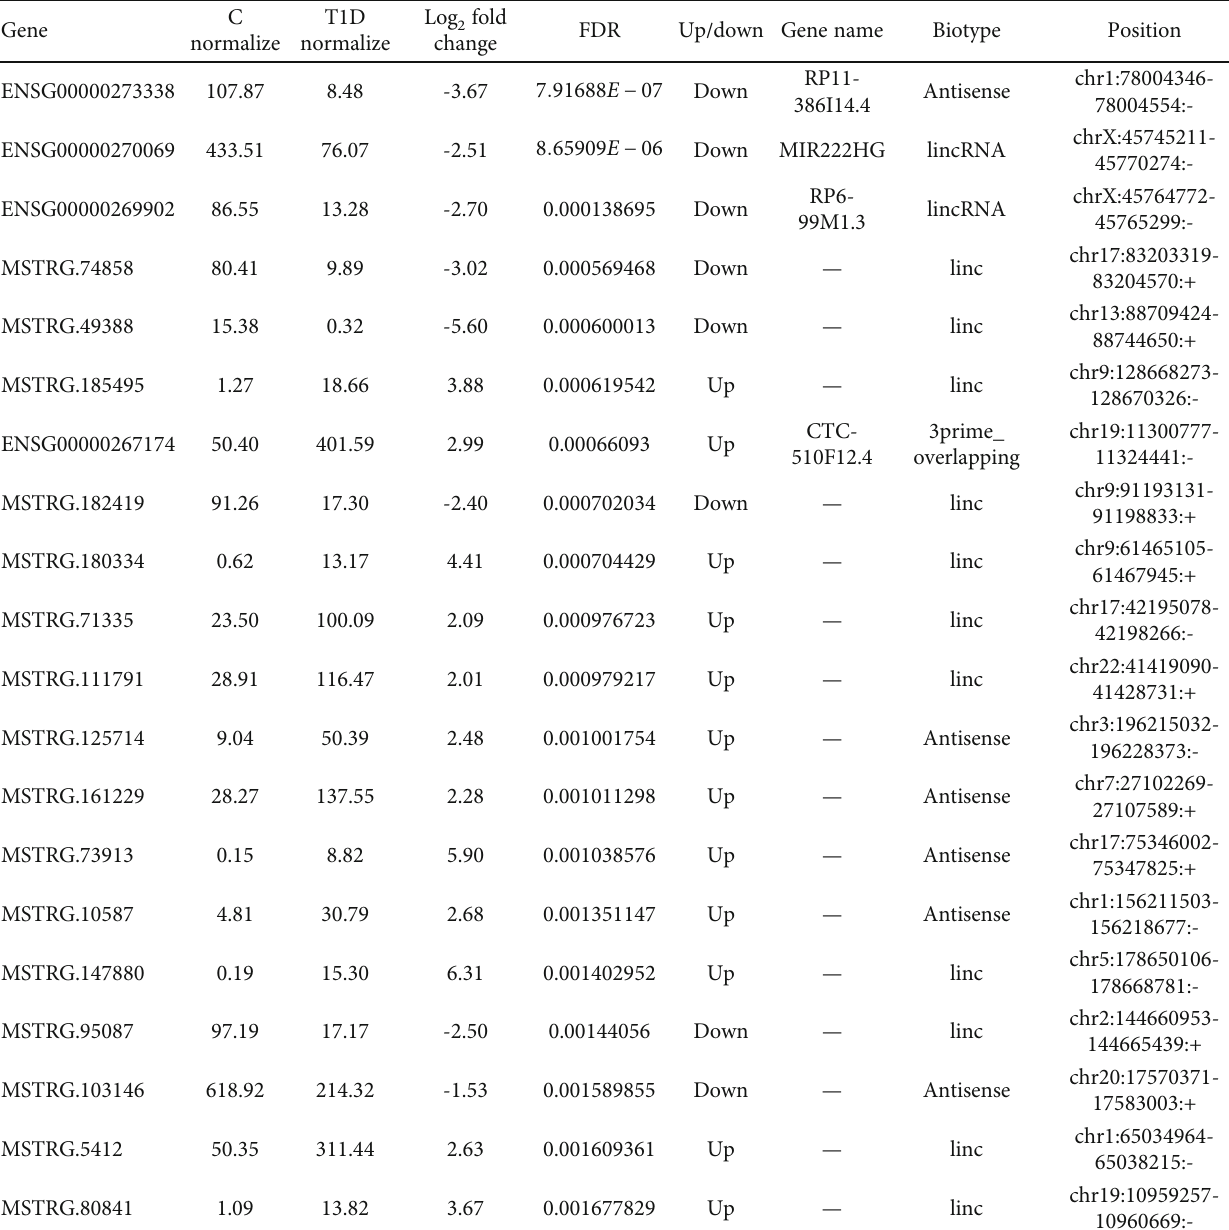
Table 2: The top 20 lncRNAs with signi fi cant di ff erential expression in white blood cells from both T1D patients and healthy controls. Gene